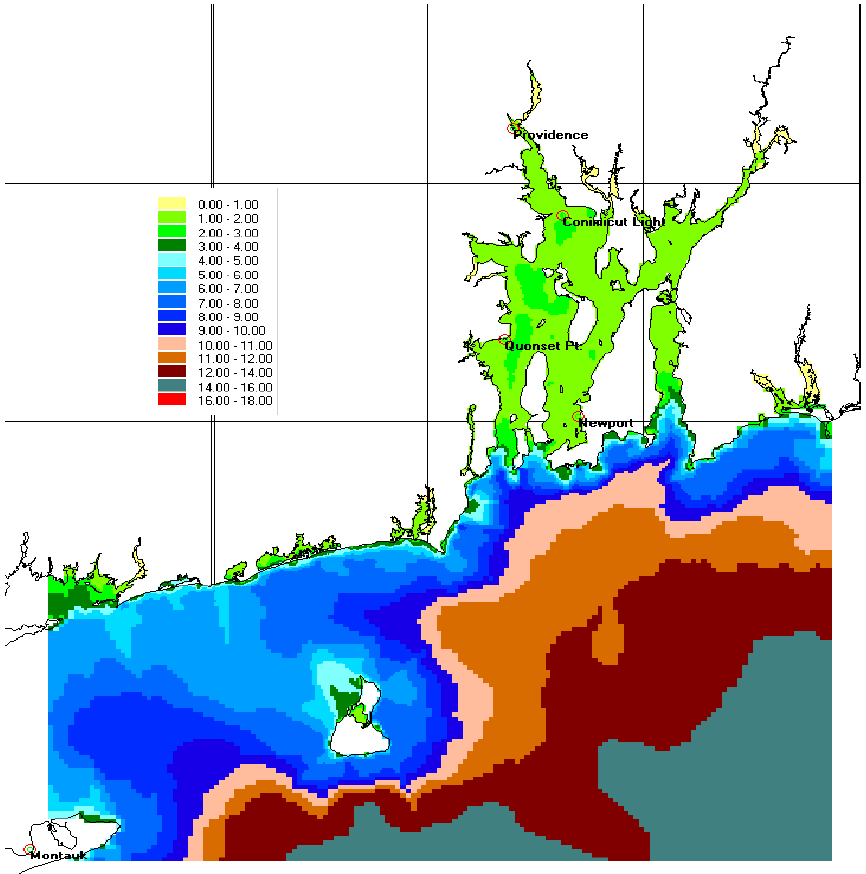
Figure 6. Contour map of the 100 year return period significant wave height (m, Mean Sea Level (MSL) referenced) for the mean surge plus tide case for RI coastal waters. referenced) for the mean surge plus tide case for RI coastal